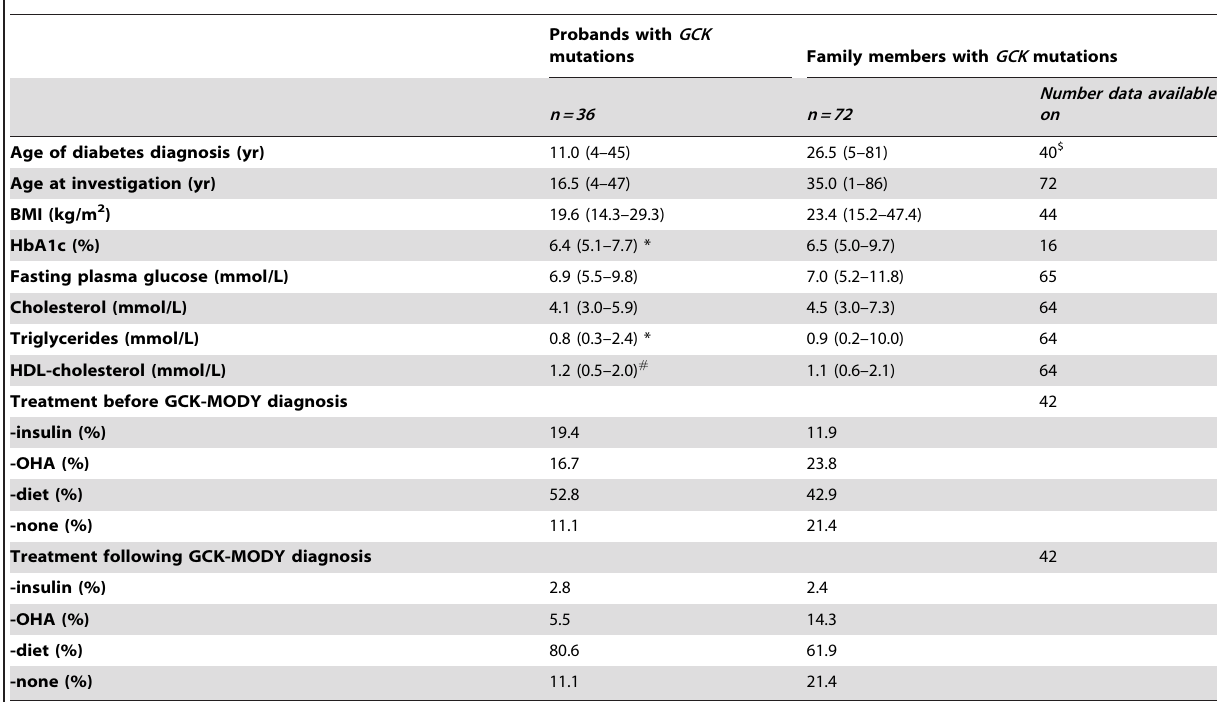
Table 2. Clinical and biochemical parameters of Slovakian GCK mutation carriers.